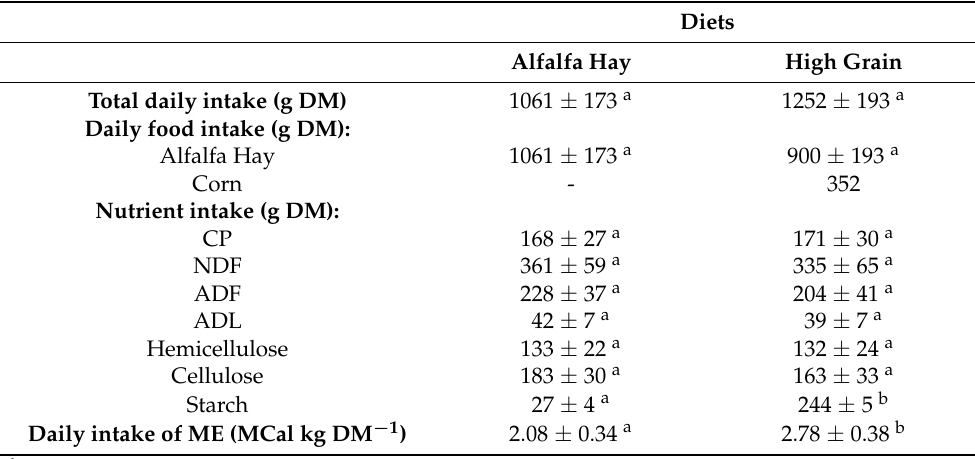
Table 1. Total daily intake and daily intake of food, nutrients and metabolizable energy (ME) of Creole goats included in the experimental period. Mean values ±